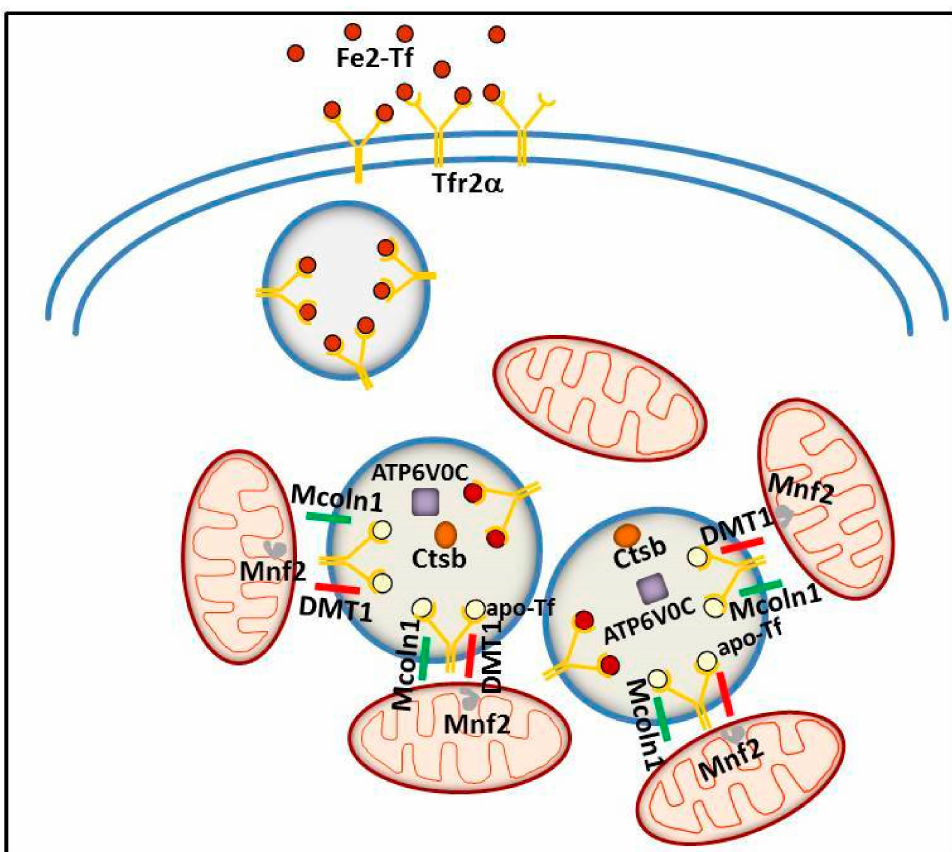
Figure 4. Schematic model illustrating the putative intracellular Tfr2 α role in erythroid cells. Tfr2 α —together with ATPV0C, a V-ATPase that contributes to vesicular acidification and lysosomal activity; Mcoln1, a lysosomal divalent cation channel; lysosomal cathepsin B (CTSB); and iron